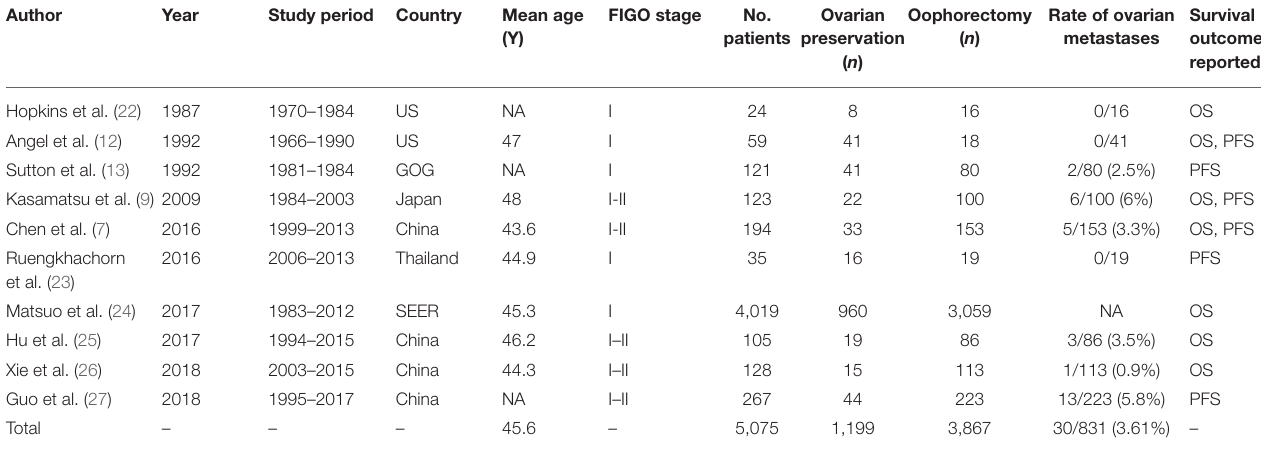
FIGO, International Federation of Gynecology and Obstetrics; GOG, Gynecologic Oncology Group; NA, not available; OS, overall survival; PFS, progression free